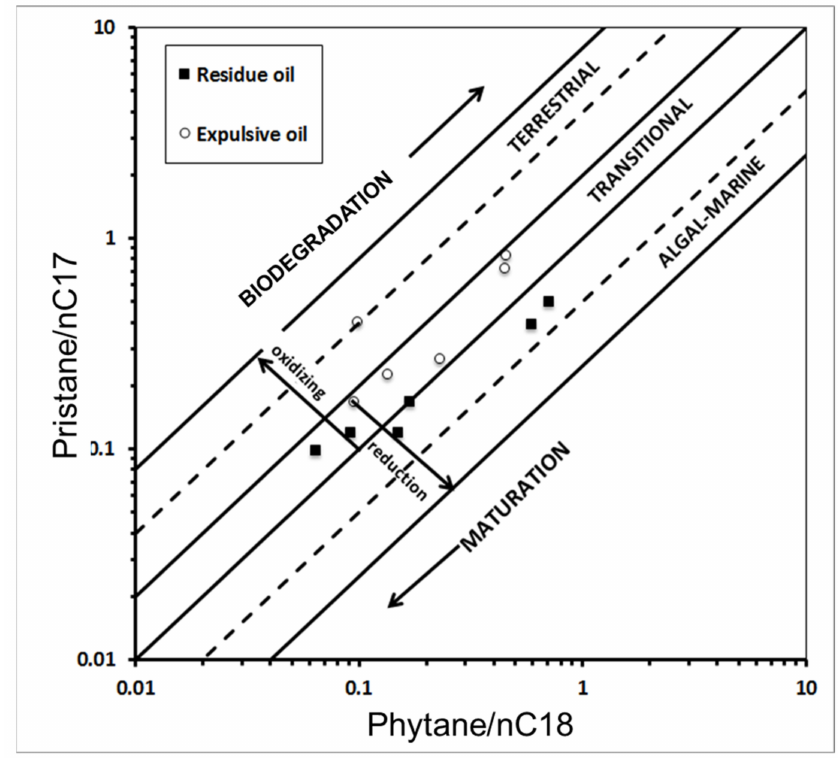
Figure 11. Pristane/ n -C17vs phytane/ n -C18 plot of residual oil and expelled oil of Tasmanite oil shales during artificial maturation experiments (diagram cf. Peters et al.